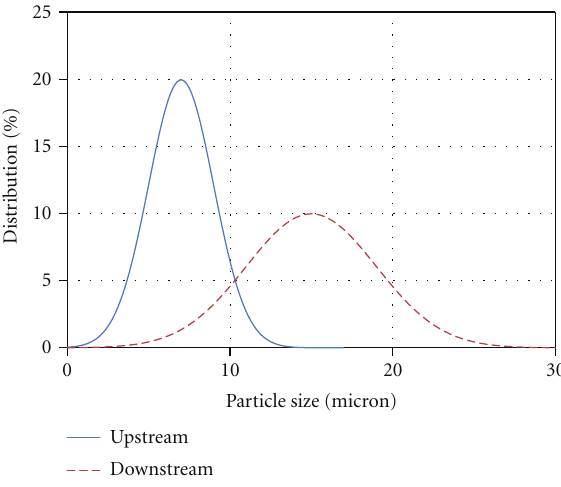
Figure 6: Coalescer droplet formation distribution